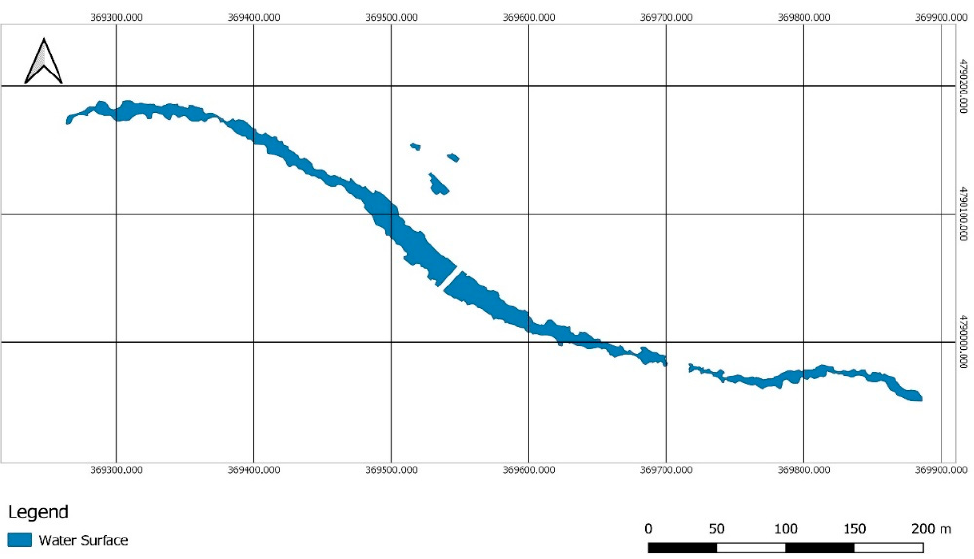
Figure 10. Water surface polygons. Segmentation of the water surfaces of the river and spa facilities based on a visual analysis of the RGB